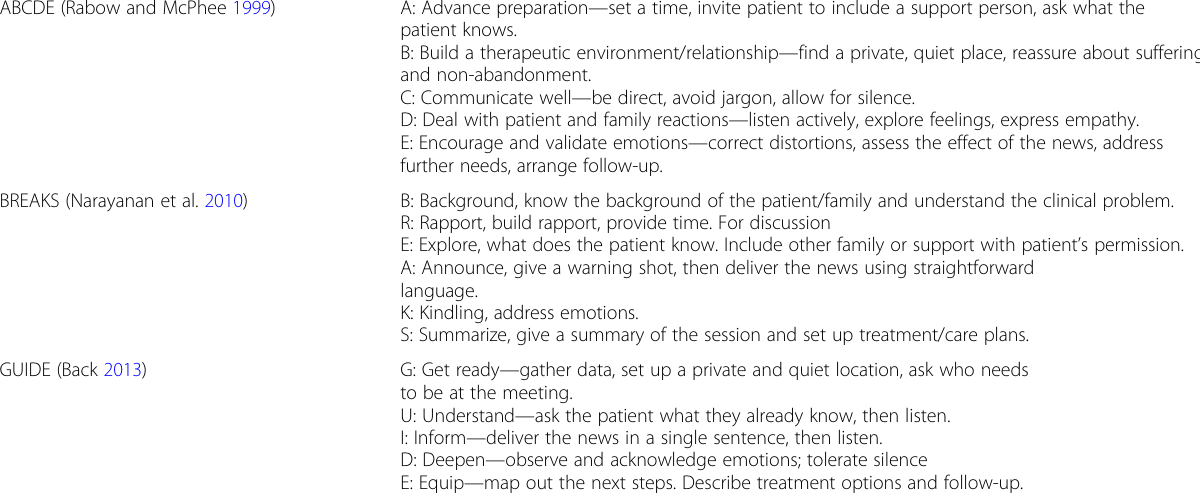
Table 7 Tools for communication when long-term follow-up is available ABCDE (Rabow and McPhee